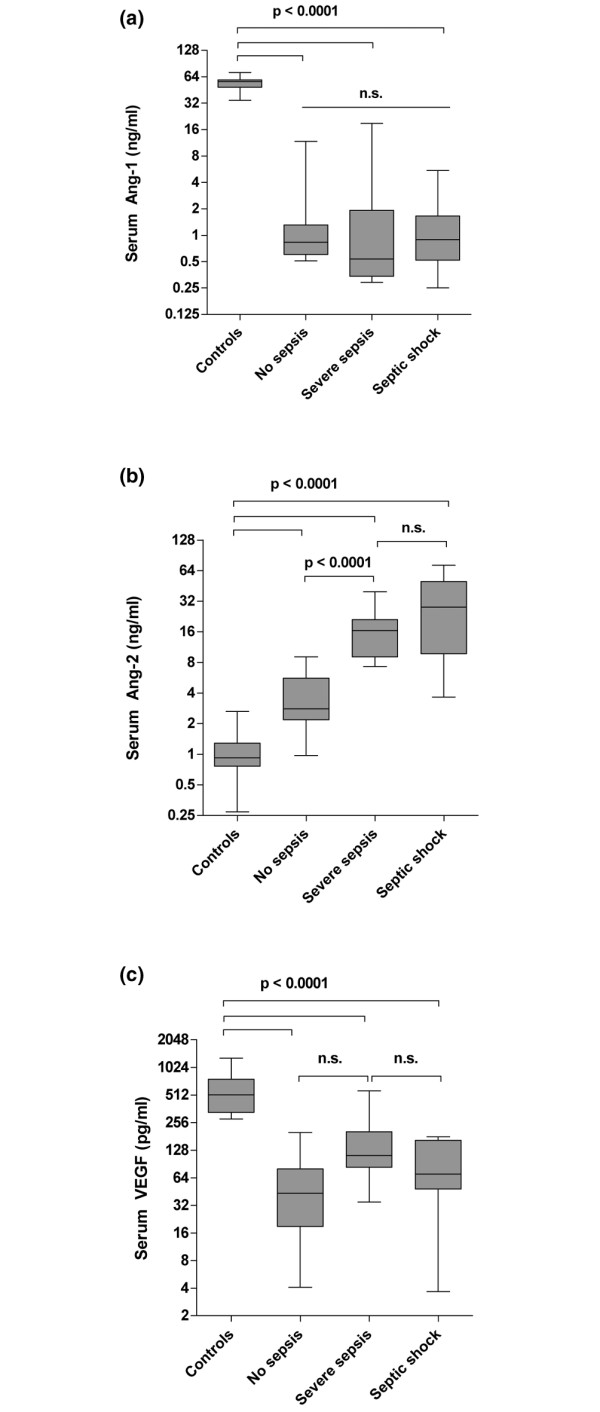
Box plots of results in healthy controls and study patients. Circulating (a) Angiopoietin (Ang) 1, (b) Ang-2 and (c) vascular endothelial growth factor (VEGF) serum concentrations in healthy controls (n = 29), critically ill patients without infection (no sepsis; n = 14), patients with severe sepsis (n = 12) and septic shock (n = 17). Horizontal bars indicate median values.